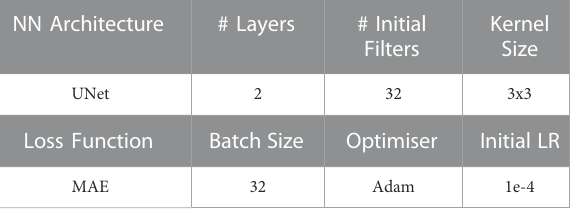
TABLE 2 The neural network architecture and training